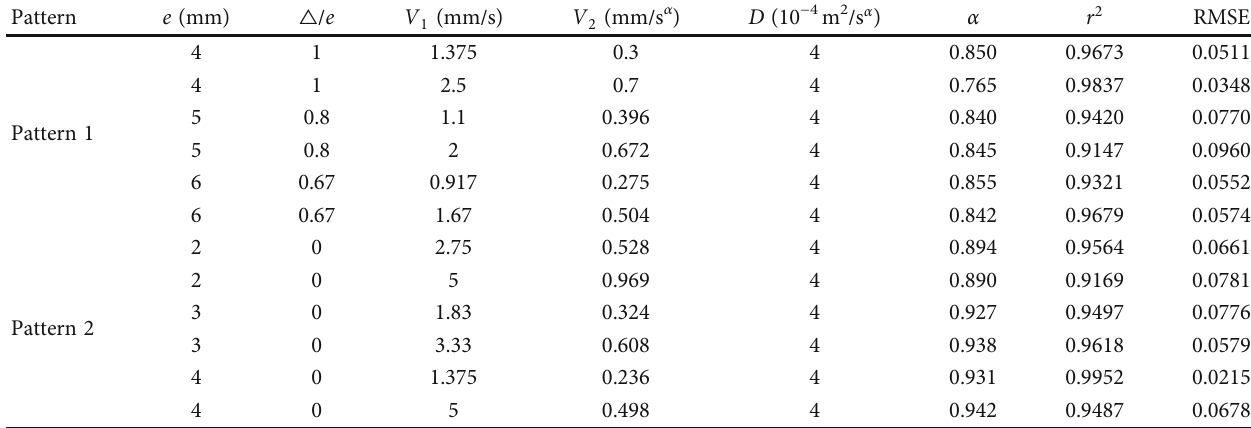
Table 6: Fitting parameters by the tFADE in the experiments of group 2.